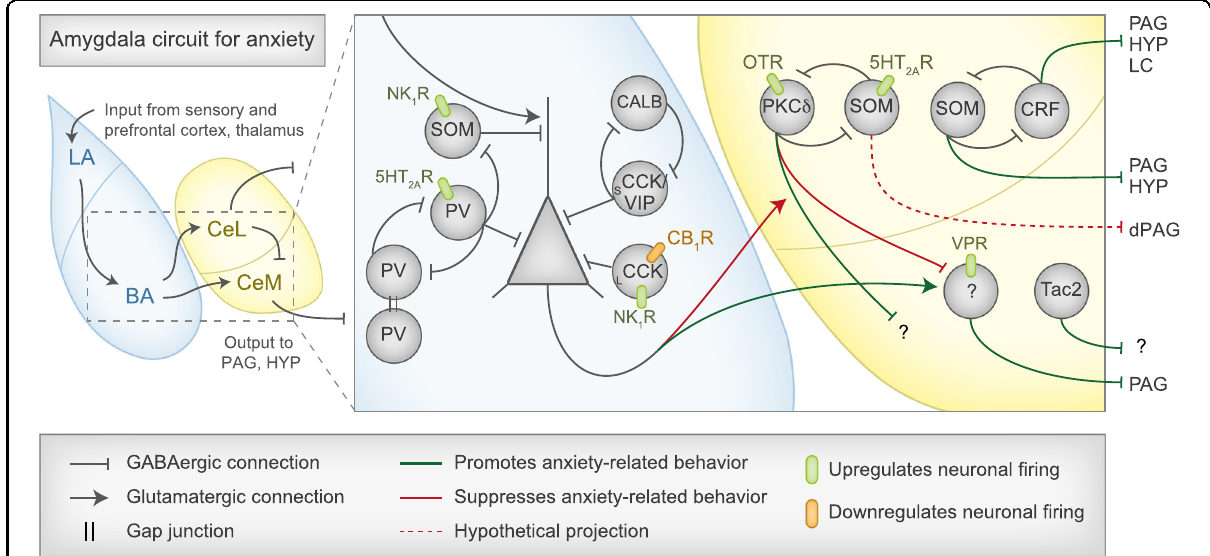
Fig. 1 Inhibitory circuits of the amygdala that are implicated in the regulation of anxiety-related behavior. The sensory information from the cortex and thalamus fl ows in series across the BLA and bifurcates as it enters the CeA. While recent optogenetic studies have begun to clarify the role of individual inhibitory loops of the CeA in anxiety-related behaviors, less is known about the intrinsic circuitry and downstream targets of individual types of neurons in the CeM. For simplicity, all of the afferents to the CeA apart from the BLA afferents are omitted, as well as some of the CeA downstream targets, including the dorsal vagal complex and the hypothalamus (which receives input from the CeM). Abbreviations: BLA basolateral amygdala; CALB